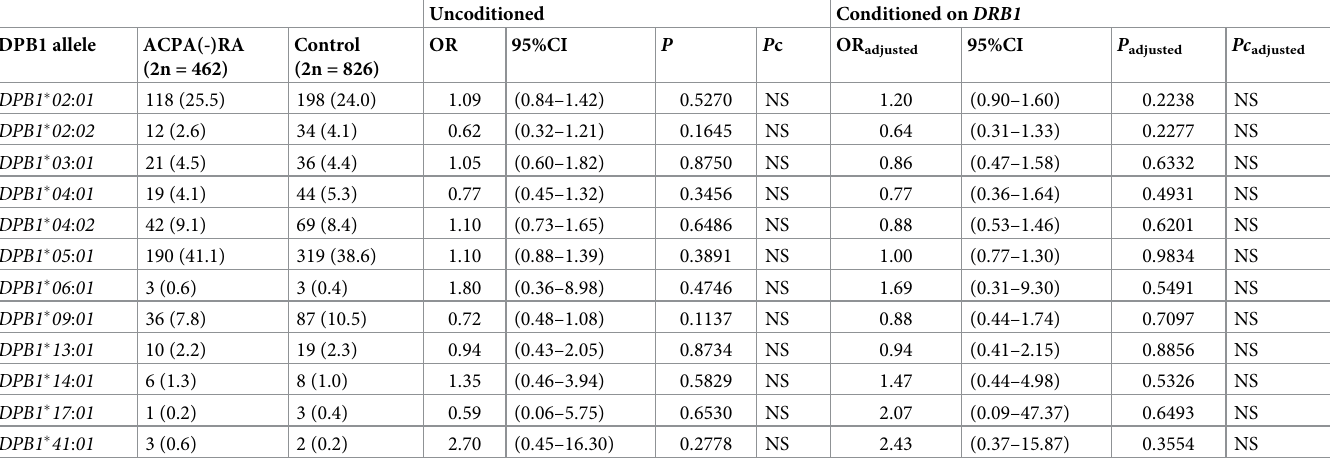
Table 4. Conditional logistic regression analysis of DPB1 alleles between ACPA(-)RA and controls.